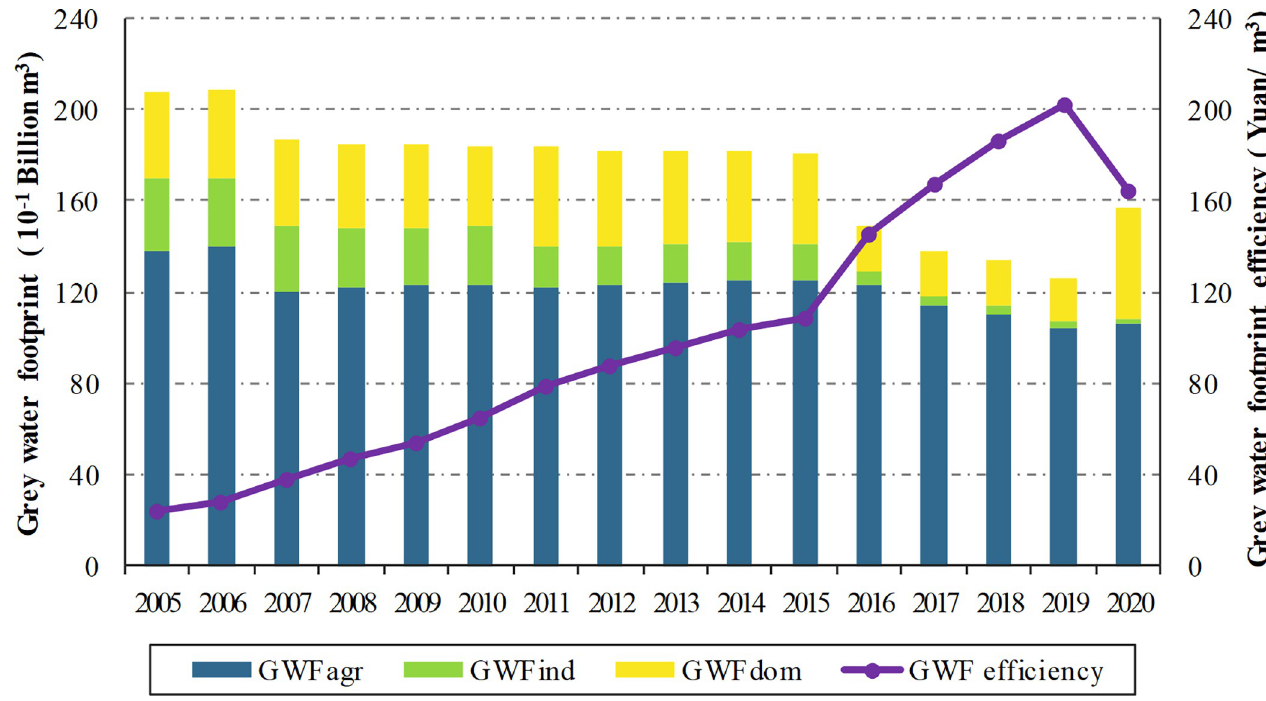
Fig 2. Changes in the GWF and its efficiency in the Yellow River Basin from 2005 to